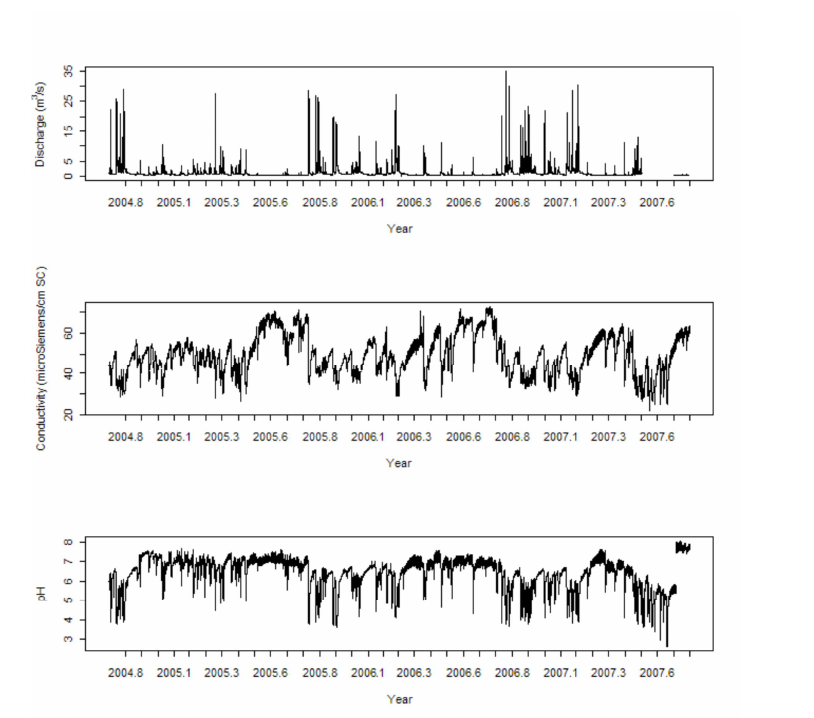
Figure 6 – Coupled 15 minute environmental time series of river discharge, conductivity and pH (Hamzah,